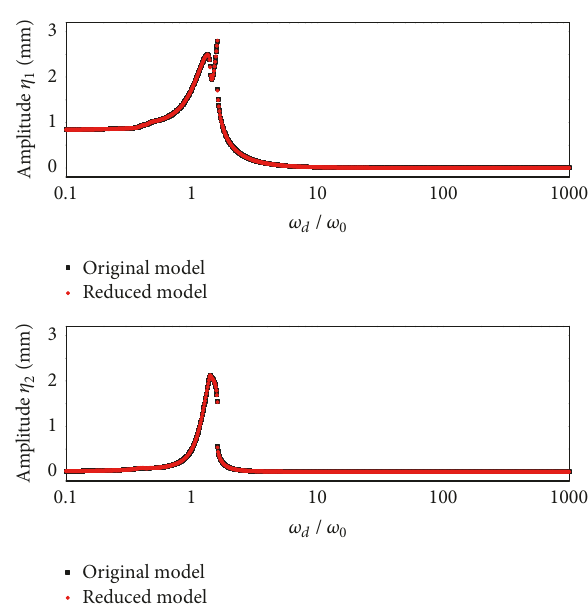
Figure 6: Comparison of the amplitude-frequency response between original model and reduced model ( 𝑚 = 1 , 𝑛 = 4 ; Ω = 0.005 ; 𝐹 = 1000 0